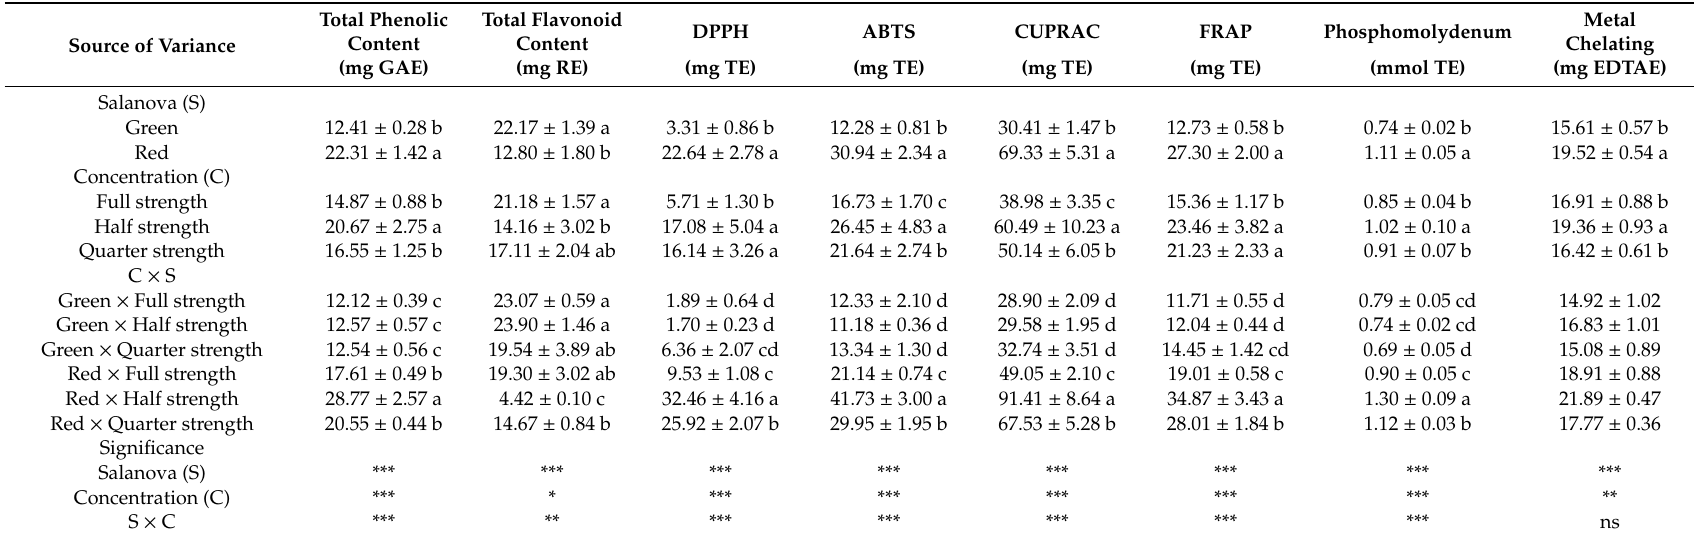
Table 2. Total phenolic acids, total flavonoid content, and antioxidant activities in green and red Salanova lettuce (S) in nutrient solutions with di ff erent macrocations concentration (C). GAE, gallic acid equivalents, RE, rutin equivalents, TE, trolox equivalents, EDTAE, ethylenediaminetetraacetic acid